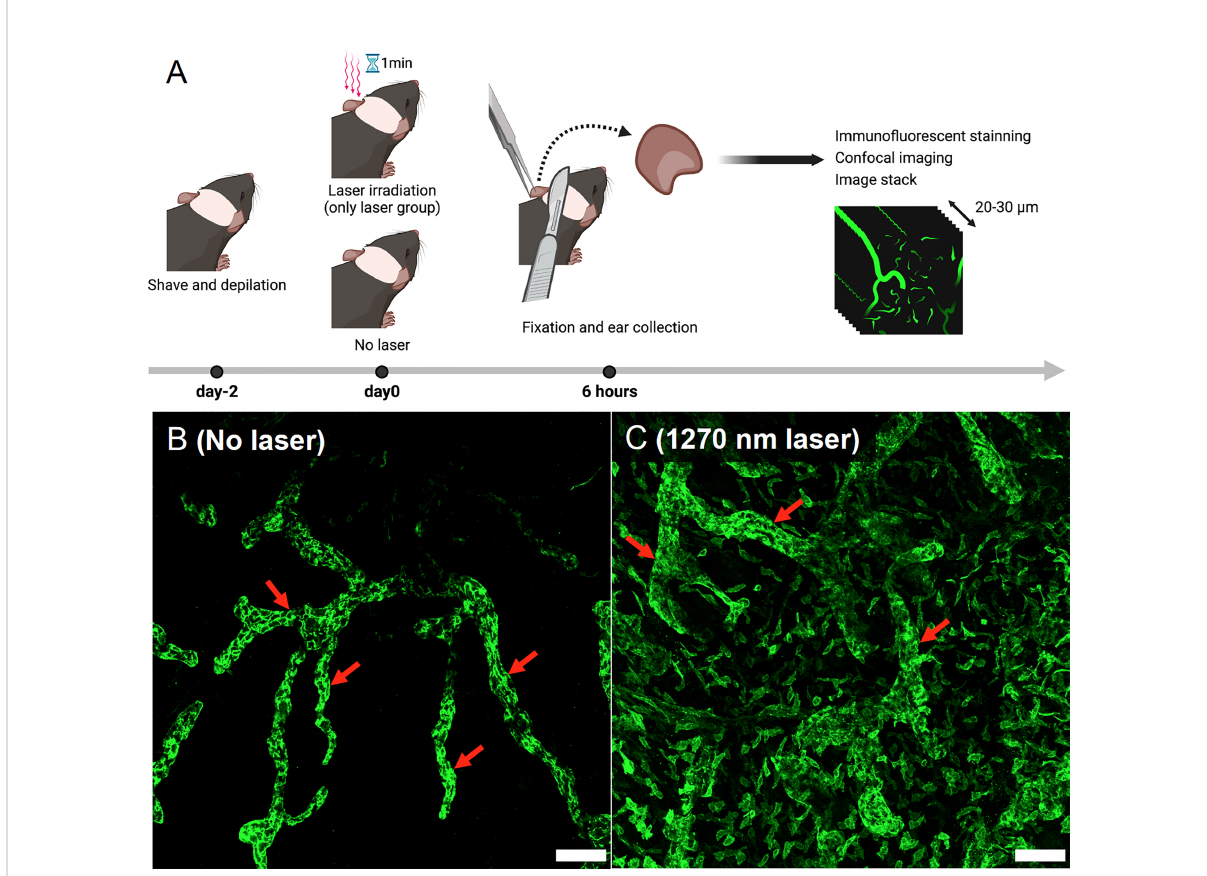
FIGURE 5 Evaluation of morphological changes in intradermal lymphatic vessels using immuno fl uorescence assay. (A) Immuno fl uorescence staining was performed on mouse ears 6 h after 1270 nm NIR laser irradiation, and images were taken with a confocal microscope. Morphological changes were visualized in stacks of the three-dimensional confocal images. (B) No-laser group. The main trunks of intradermal Lyve-1-positive lymphatic vessels (arrows) are imaged in green. (C) 1270 nm NIR laser group. The main trunk of intradermal Lyve-1 positive lymphatic vessels (arrows) is dilated, and microvessels are also dilated throughout the fi eld of view. The scale bar represents 100 m